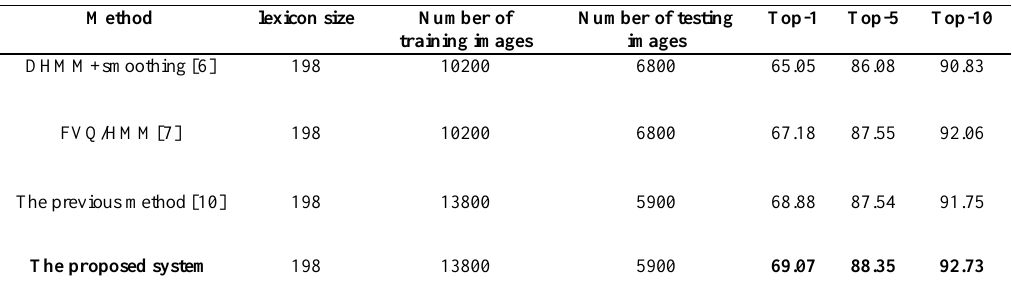
Table2. Recognition rate of proposed method compared to other method